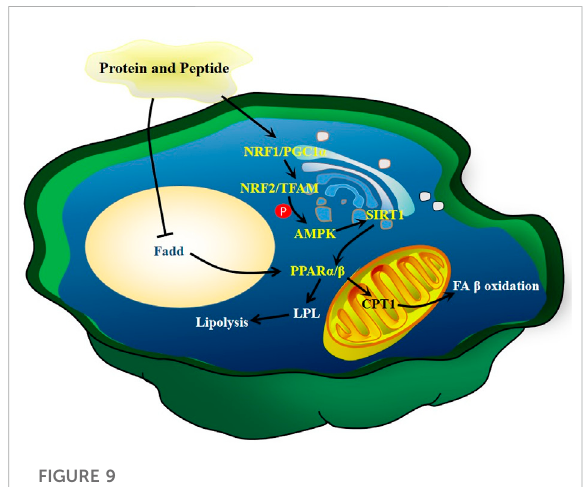
FIGURE 9 The mechanisms of action of peptides and proteins of sea cucumbers. Fadd, FAS associated death domain protein; NRF, nuclear respiratory factor; TFAM, mitochondrial transcription factor